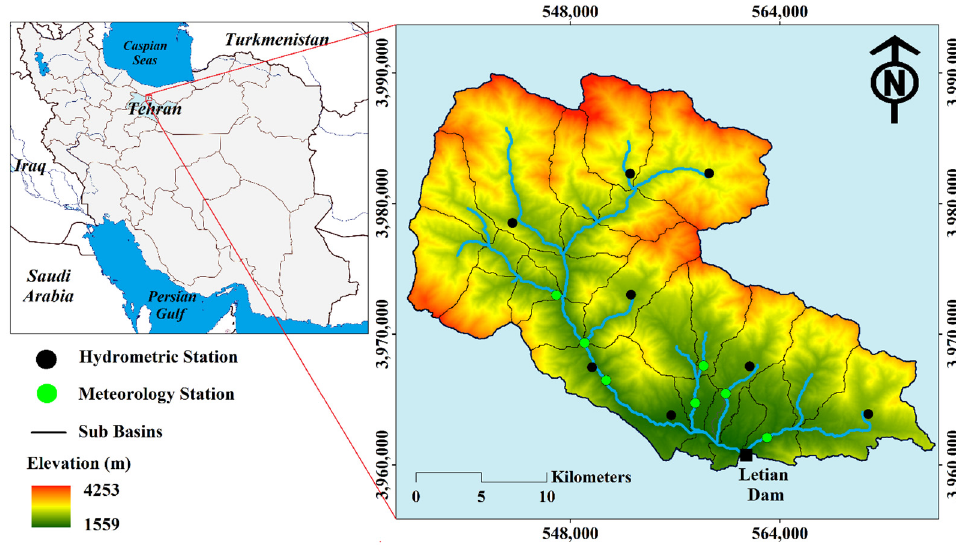
Figure 1. The geographical location of the Jajrood river watershed.